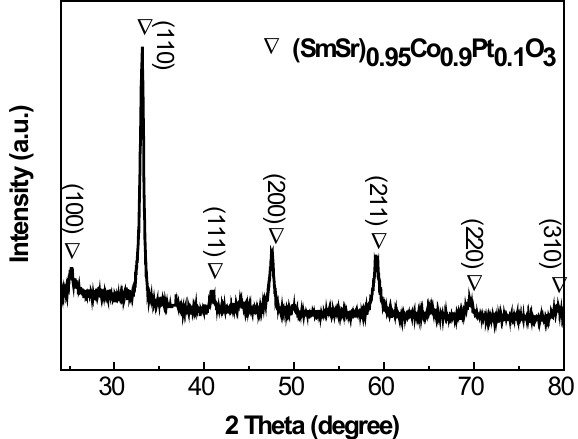
Figure 1. XRD patterns of as-prepared (SmSr) 0.95 Co 0.9 Pt 0.1 O 3 .